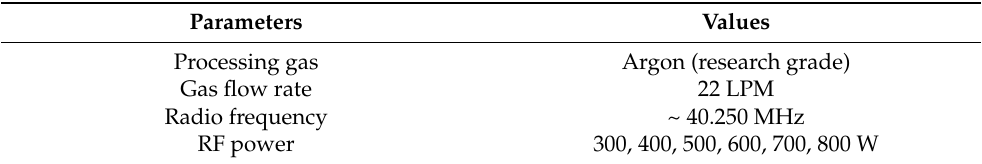
Table 1. Experimental parameters for the plasma torch.